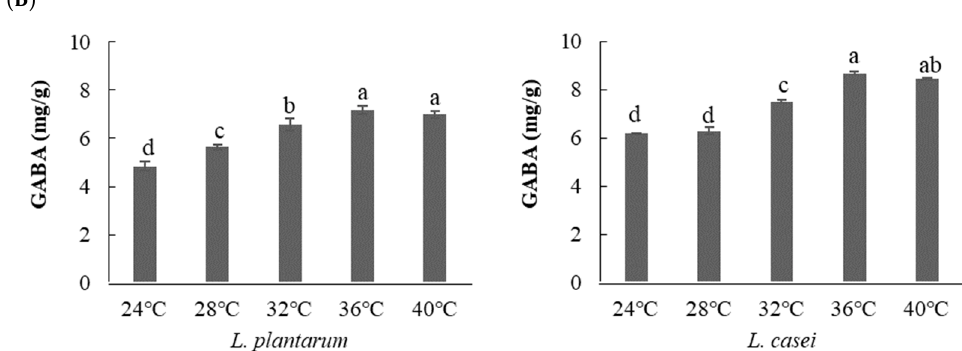
Figure 3. Glutamic acid ( A ) and GABA ( B ) contents of the Oryza sativa extracts depending on the fermentation temperature. Each bar is the mean ± standard deviation of the results from three different analyses ( n = 3). The bars with different letters (a–d) indicate significant differences at p < 0.05 using Duncan’s multiple range test.